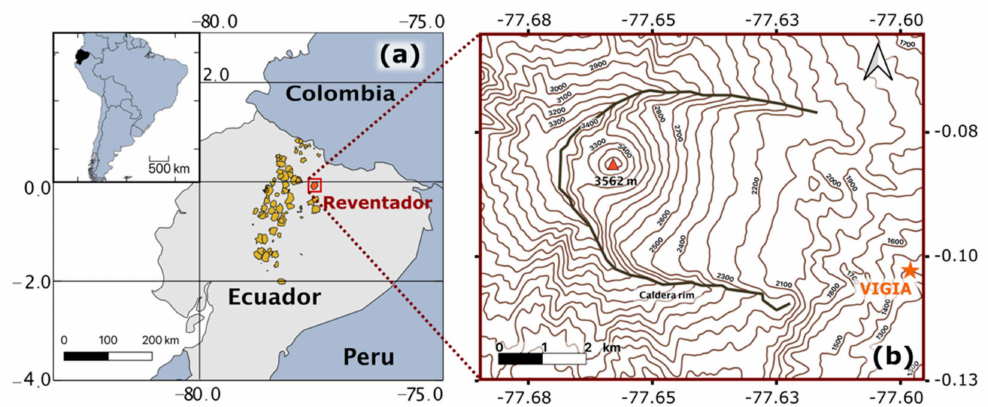
Figure 1. ( a ) Reventador volcano is located in the limit between the Andean cordillera and the Amazon basin in Ecuador. ( b ) The current active cone is located inside a 4 km wide U-shaped debris avalanche scar. VIGIA is installed within the property of Hoster í a Reventador, 7 km eastward from the active